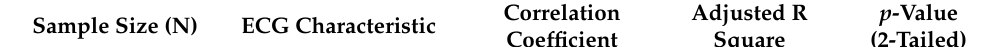
Table 2. Partial linear correlations of T/R ratio by lead, PR, and QRS vs. serum potassium. Sample Size (N) ECG Characteristic